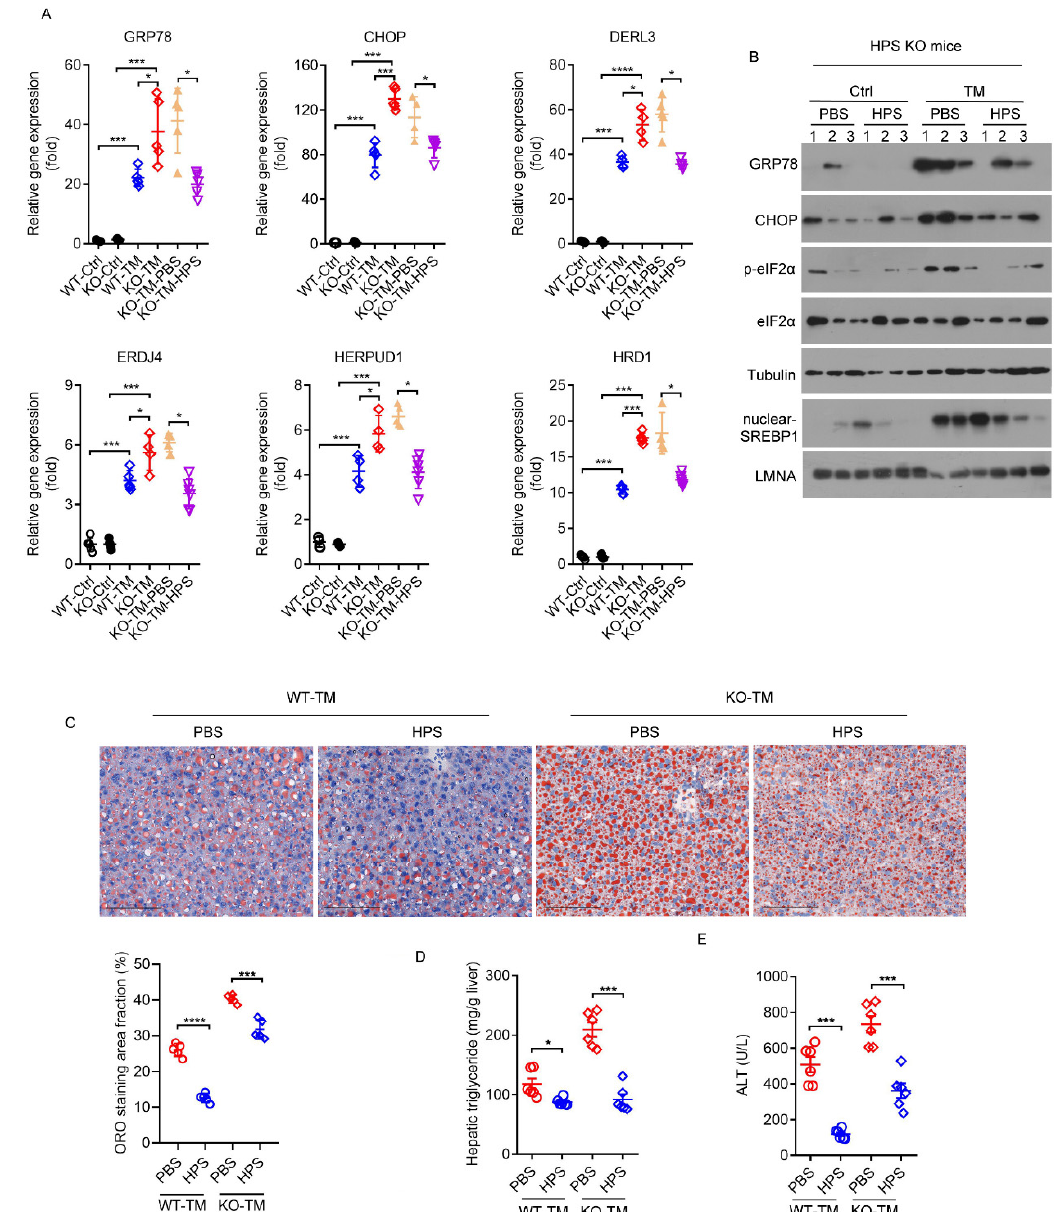
Figure 7. Pre-treatment HPS inhibits aggravated hepatic steatosis in HPS-KO mice during TM- induced ER stress. Eight-week-old WT and HPS-KO mice were injected intraperitoneally with TM (1 mg/kg body weight) for 24 h. For the rhHPS-treated group, 1 h before intraperitoneal injection TM, WT or HPS-KO male mice were injected intraperitoneally with rhHPS (1 mg/kg) or PBS. ( A ) Relative expression of Grp78 , Chop , Derl3 , Hrd1 , Herpud1 and Erdj4 mRNA in mice liver ( n = 4–6). ( B ) Immunoblotting analysis of GRP78, CHOP, p-eIF2 α and eIF2 α in whole-cell lysates and SREBP1 in nuclear extracts. Tubulin was used as the whole-cell lysate control and LMNA was used as the nuclear extract control. The Arabic numeral represents the number of the mouse to which the protein sample belongs in each group. ( C ) Representative images of ORO-stained liver sections of the mice as indicated. Scale bar = 100 µ m. The ORO staining area fraction was quantitated using ImageJ software and values are the mean ± SD of five liver sections of measurements. ( D ) Hepatic triglyceride levels of the mice ( n = 6). ( E ) Serum ALT levels of the mice ( n = 6). Data are expressed as mean ± SD of all samples for each group. The significant difference between the mean relative values of two groups was analyzed by Student t test (* p < 0.05, *** p < 0.001, **** p < 0.0001).